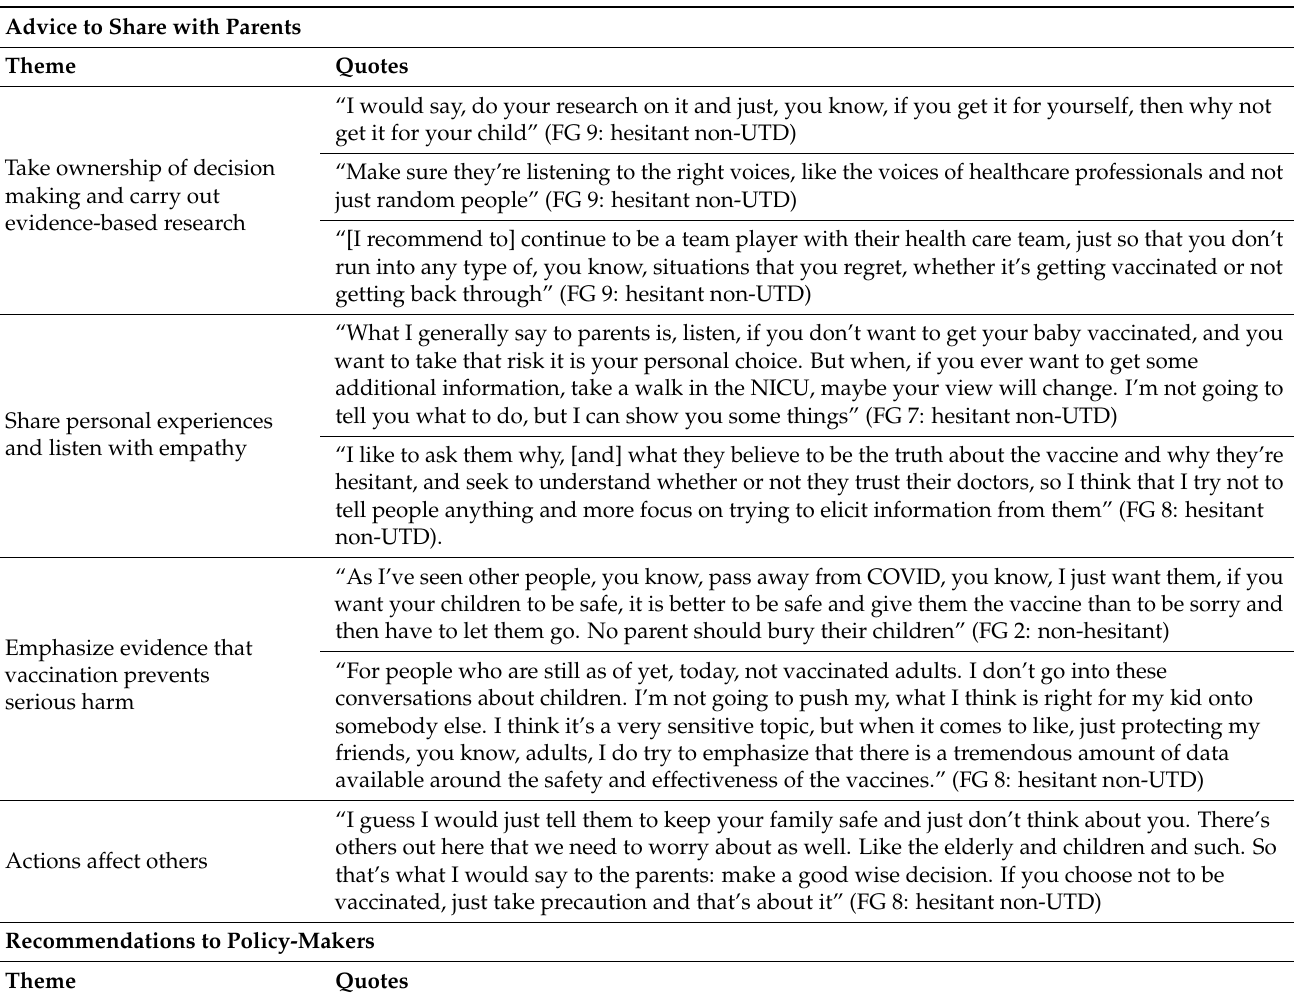
Table 4. Recommendations and strategies to improve trust, confidence, accessibility, and communica- tion from parental focus groups